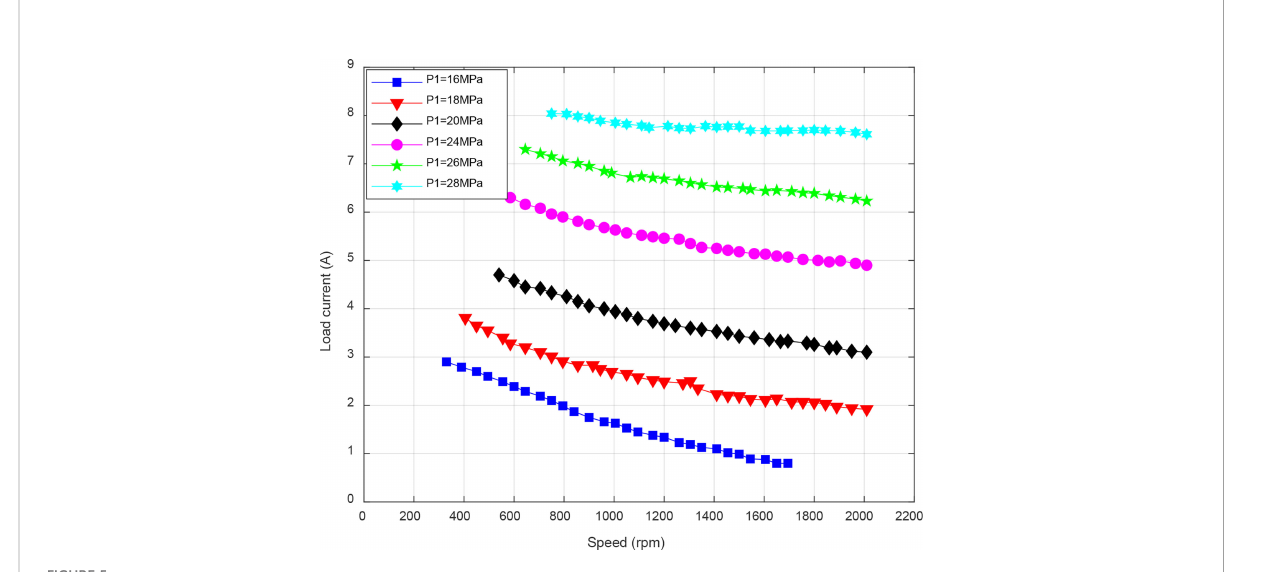
FIGURE 5 The relationship between speed and load